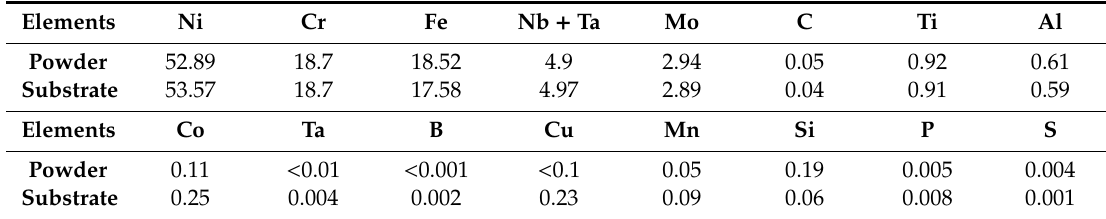
Table 1. Chemical composition (wt.%) of Alloy 718 powder and